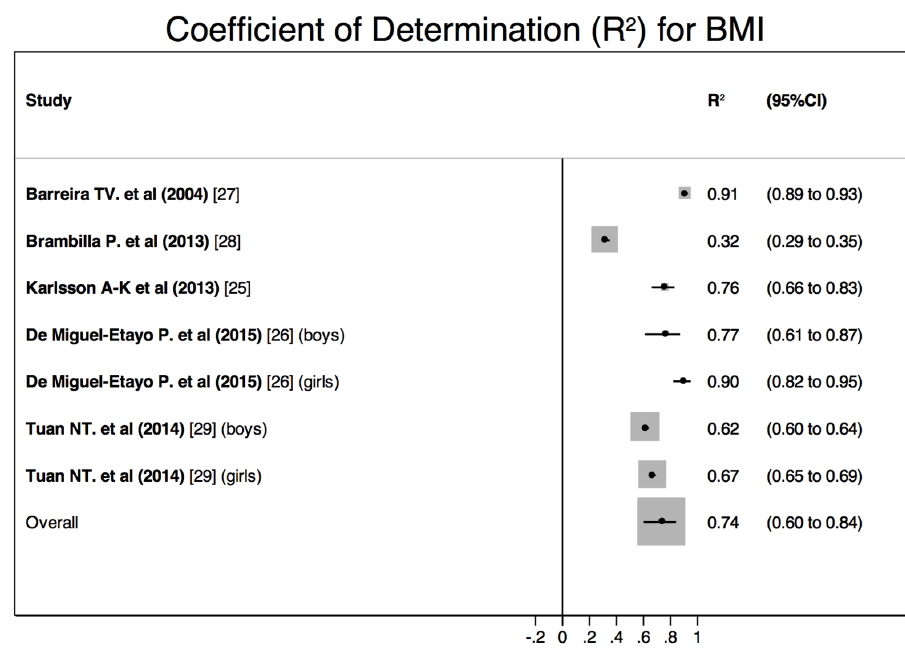
Figure 3. Results of the quantitative meta-analysis: Pooled coefficient of determination ( R 2 ) for BMI to assess BF measured by DEXA.